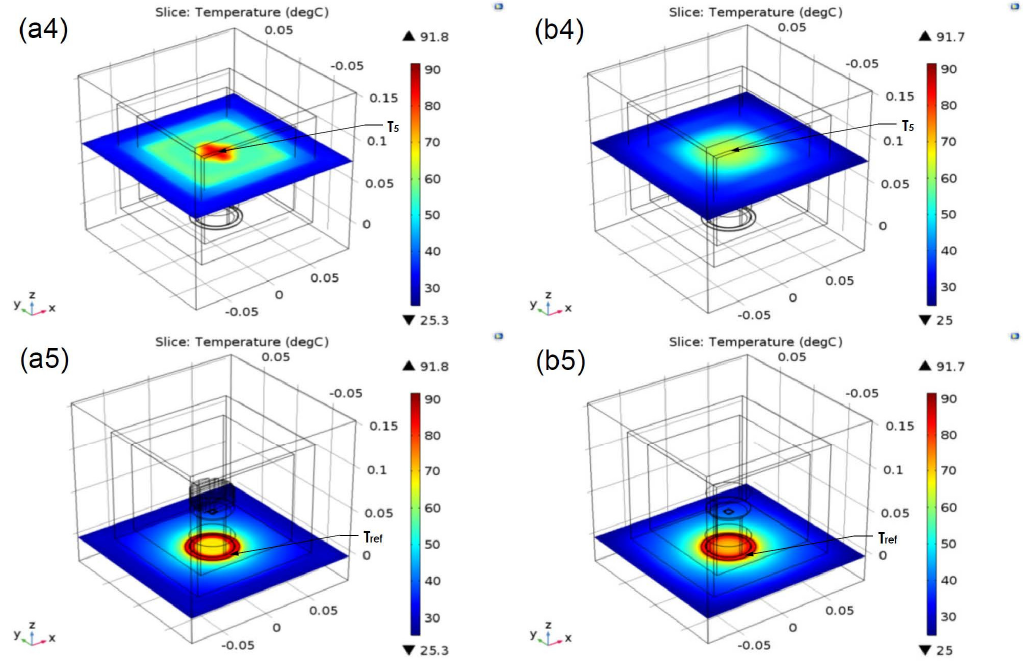
Figure 8. ( a1 )–( a5 ) show the simulation results using an isometric view ( xy plane) for the temperature distribution at T 1 , T 2 , T sp , T 3 , T 4 , T 5 , and T ref points of ALFHS; ( b1 )–( b5 ) are of the CUFHS; each of them are mounted to the CLRDL after